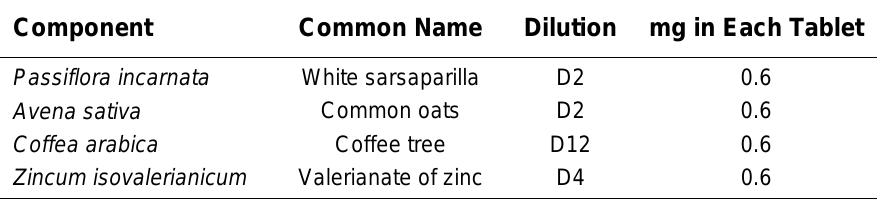
Components of Neurexan and Their